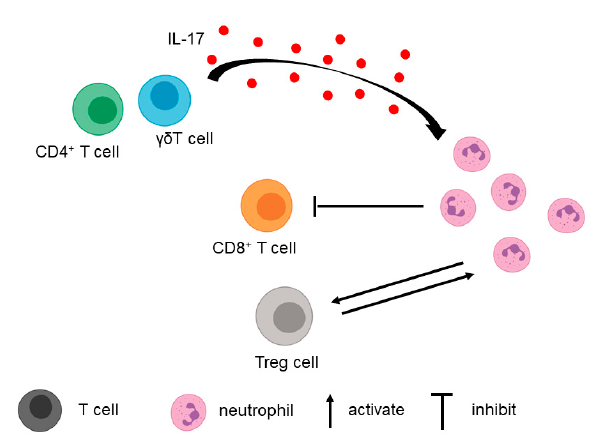
Figure 2. Interactions between neutrophils and T cells. IL-17 secreted from CD4 + T cells and γδ T cells attracts neutrophils. Neutrophils can inhibit CD8 + T cell proliferation, activation, and recruitment. Neutrophils and Treg cells can activate each other.